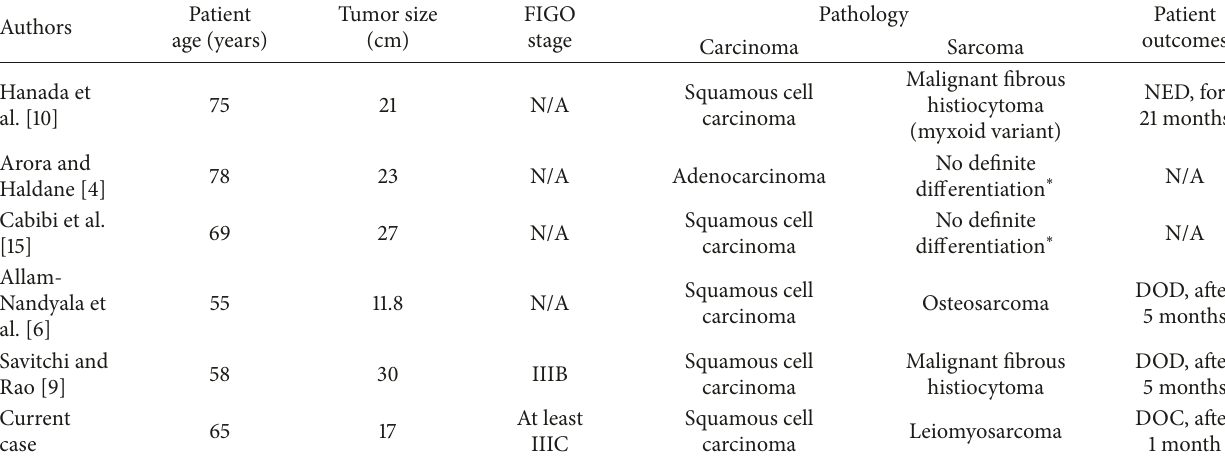
Table 1: Mixed types of cancer arising in ovarian dermoid